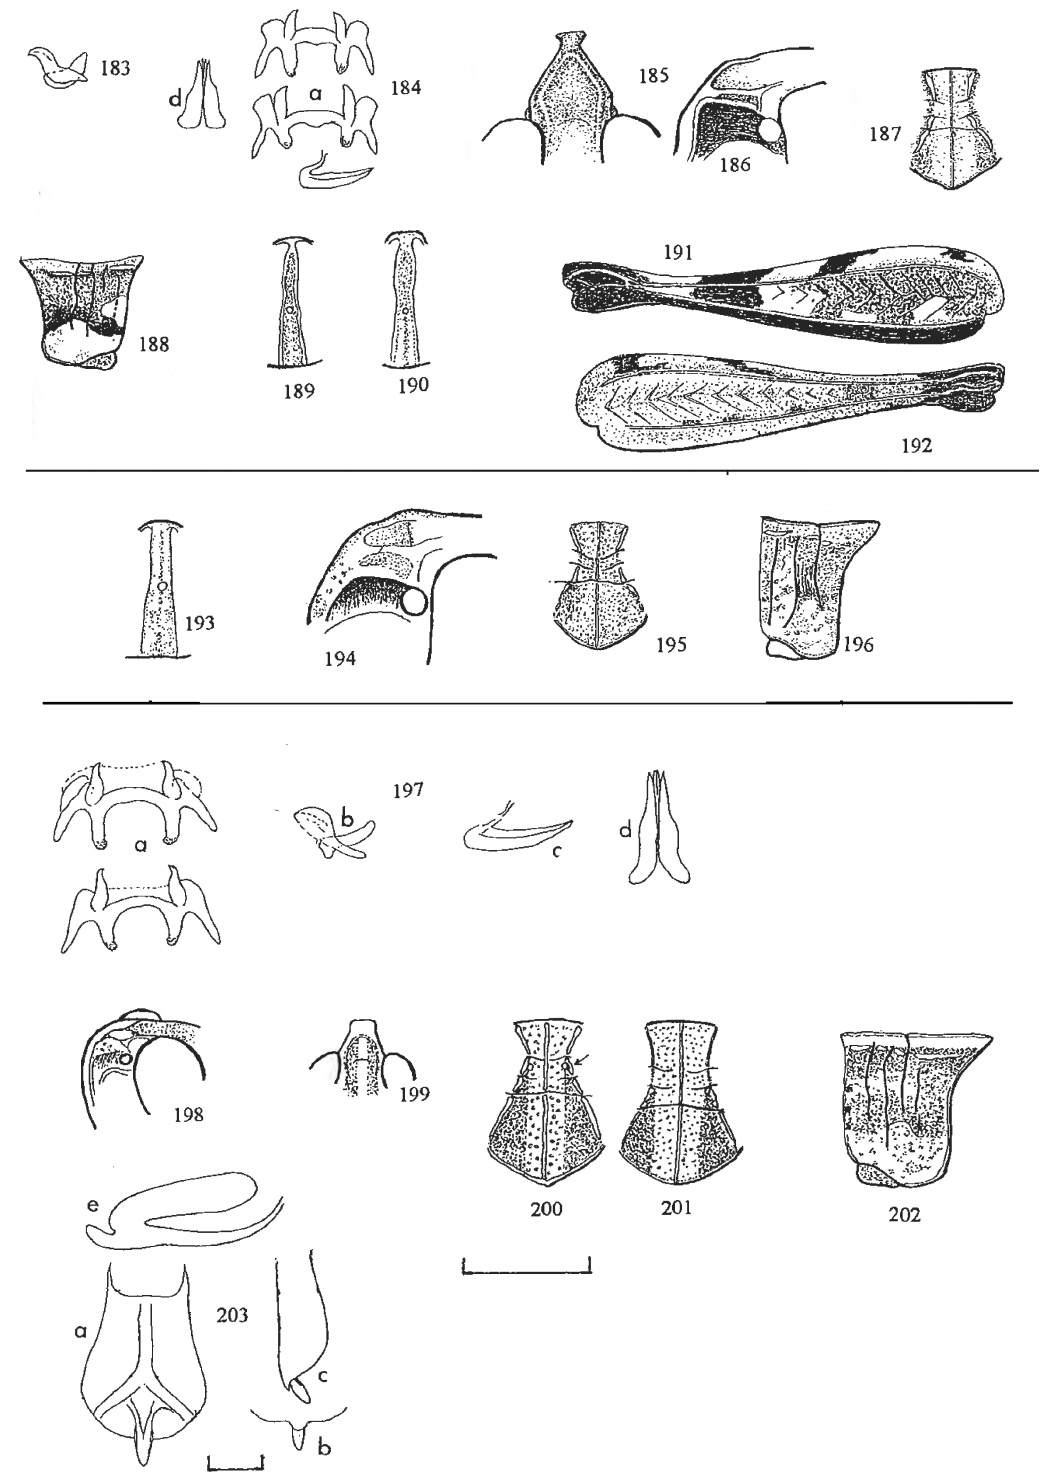
Figs 183–203. Tribe Gymnobothrini. Figs 183–192. Gymnobothrus longicornis : 183, 184. Variation in epiphallus and aedeagal valves; 185. Dorsal view male vertex; 186. Oblique view male vertex; 187. Male pronotal disc; 188. Lateral view pronotum; 189. Frontal ridge (C.A.R., Bosum); 190. Frontal ridge (Tanzania, nr Kahama); 191. Posterior femur, pattern on outer side (Cameroon); 192. Ditto, Tanzania. Figs 193–196. Gymnobothrus longicornis sellatus male: 193. Frontal ridge; 194. Oblique view vertex; 195. Pronotal disc; 196. Lateral aspect pronotum. Figs 197–203. Gymnobothrus cruciatu s male: 197. Epiphallus and aedeagal valves; 198. Oblique view vertex; 199. Dorsal view vertex; 200. Pronotal disc (Tanzania syntype elongata) ; 201, 202. Lateral aspect pronotum (Tanzania and Angola, Villa Luso holotype cruciatus s.str.); 203. Female: E. Spermatheca and A–C. Aspects of subgenital plate. All scales 1 mm: that under Fig. 200 applies to Figs 183–186, 194, 197–199; that under Fig. 203 applies to Figs 187–193, 195, 196,